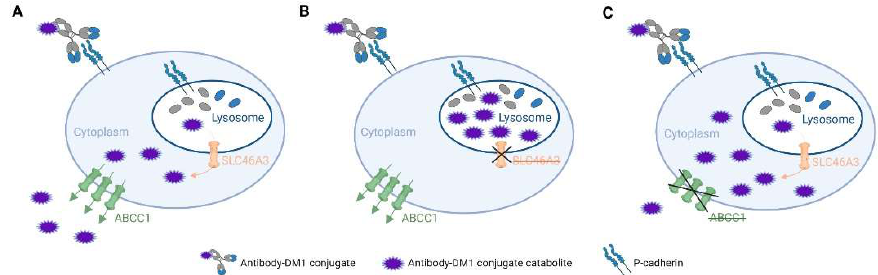
Figure 3. Proposed mechanisms of cellular distribution of catabolite of antibody maytansine conju- gate in wild-type ( A ), SLC46A3-KO ( B ) and ABCC1-KO ( C ) cancer cells. Created with